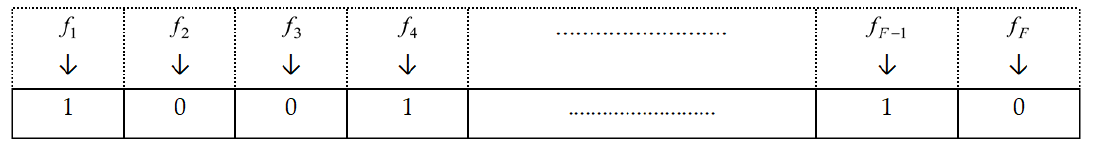
Figure 3. The schematic diagram of the binary encoding of the chromosome.